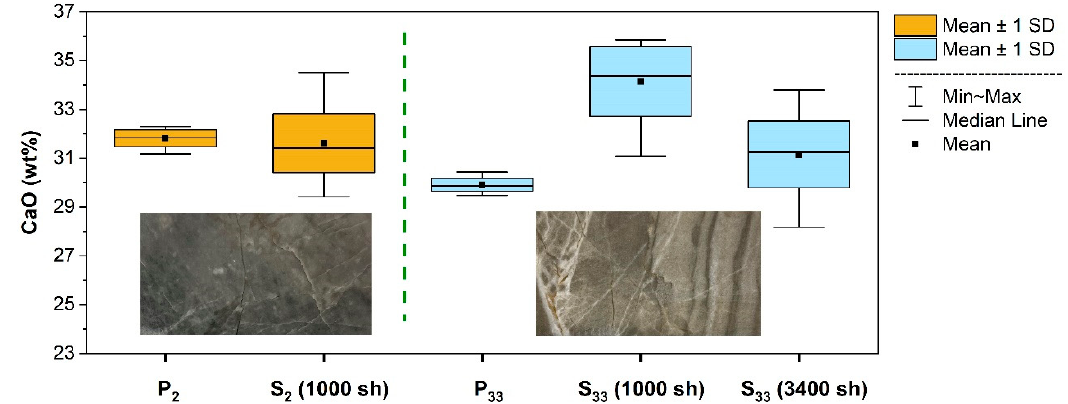
Figure 4. Comparison between LIBS measurements performed on a rather homogeneous rock slice (S 2 ) along with the corresponding pellet (P 2 ) and on a markedly veined rock slice (S 33 ) along with the corresponding pellet (P 33 ) using different numbers of laser shots (sh). In each group, the spectra were preprocessed and averaged in the same way (background subtraction, band selection, normalization, averaging 50 measurements). The sizes of the rock slice images are about 25 × 45 mm 2 .